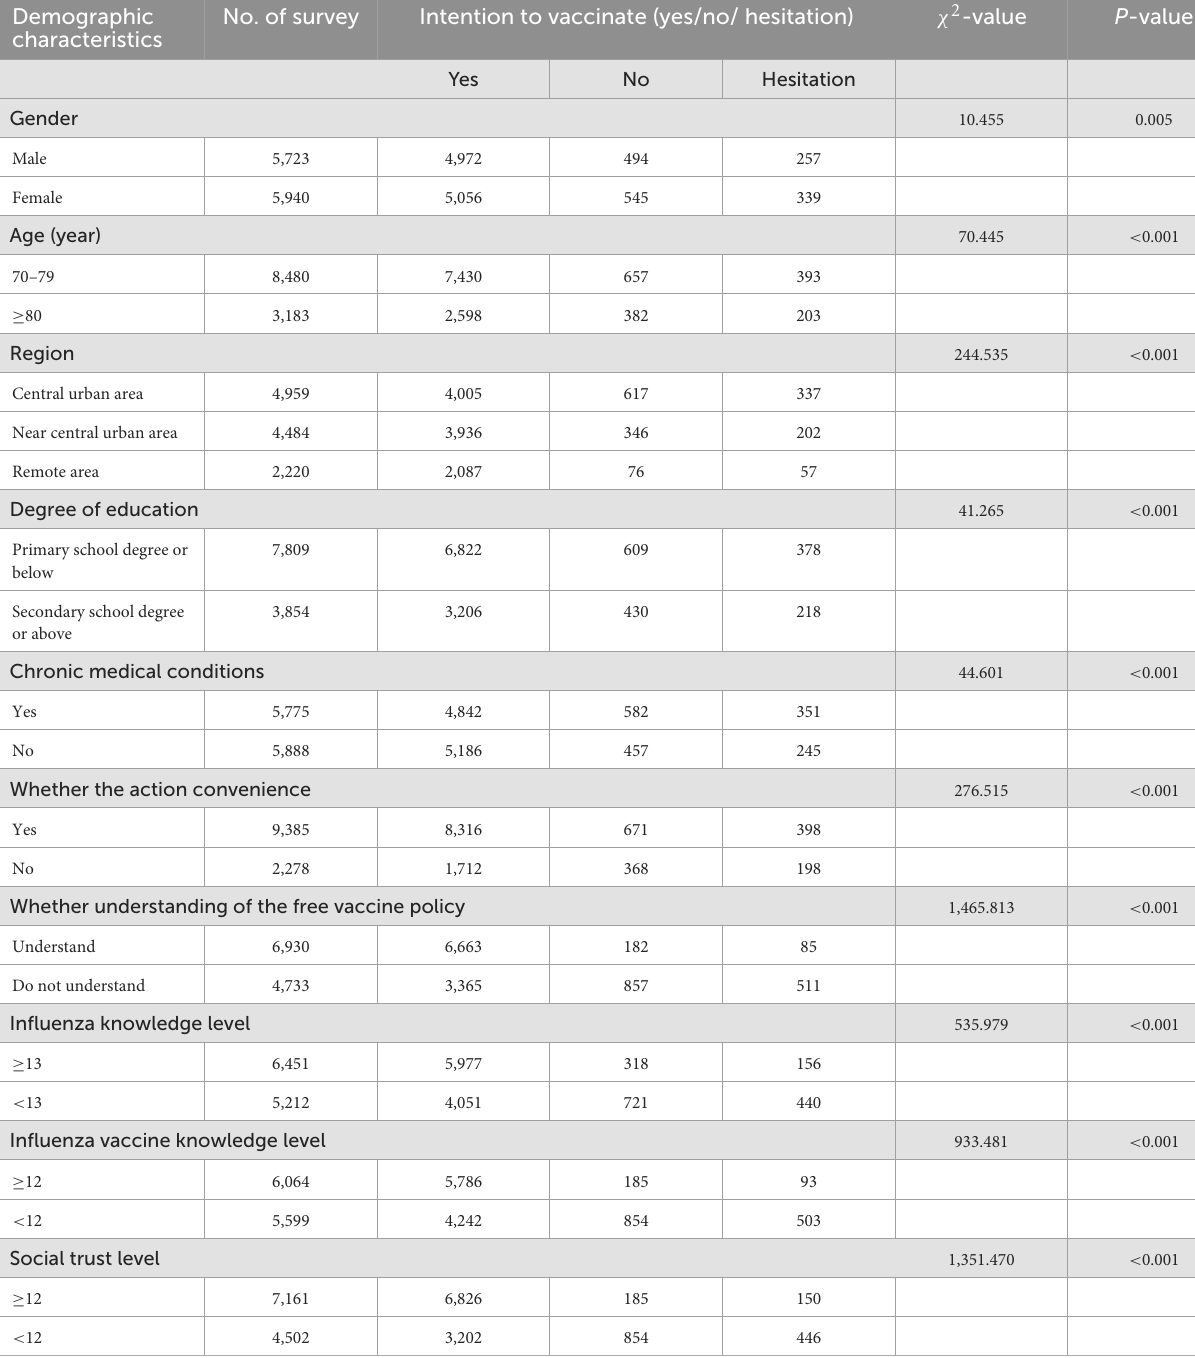
TABLE 3 Univariate analysis of the willingness of the elderly aged 70 years and above to receive free influenza vaccination in Hangzhou. Demographic